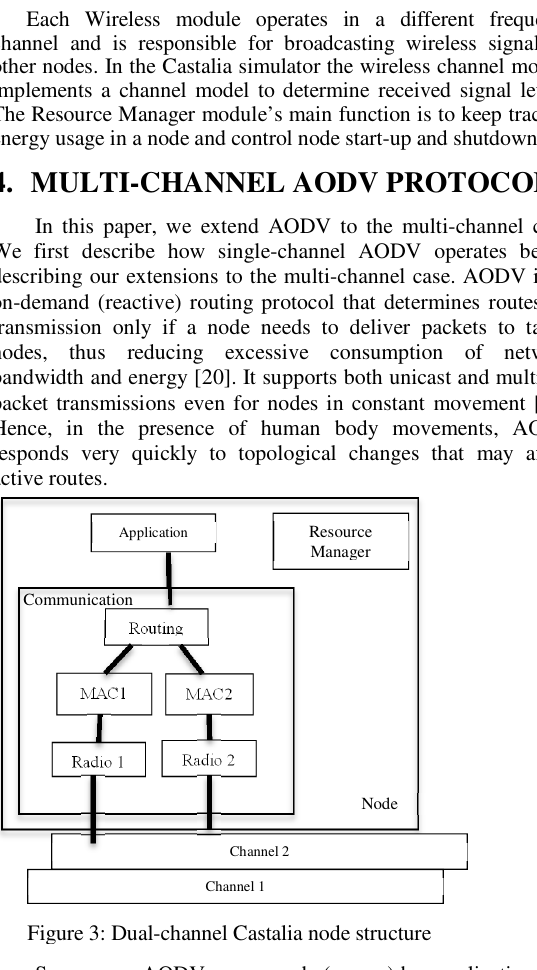
table towards the destination using the immediate source of the